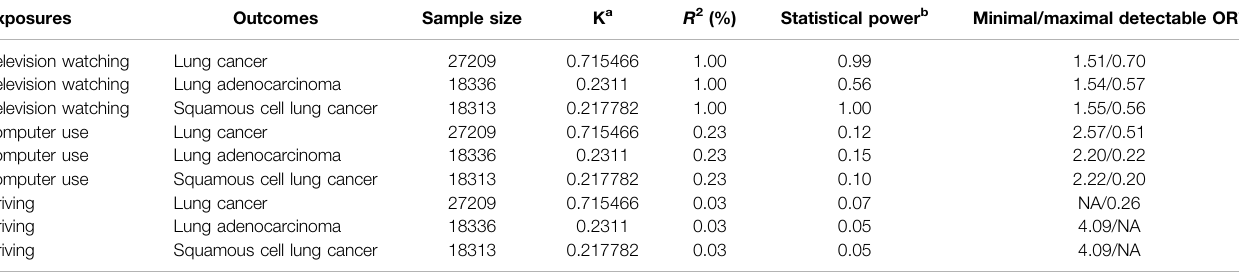
TABLE 1 | Statistical power calculation for the univariable Mendelian randomization analyses (two-sided, α (cid:1) 0.05). Exposures